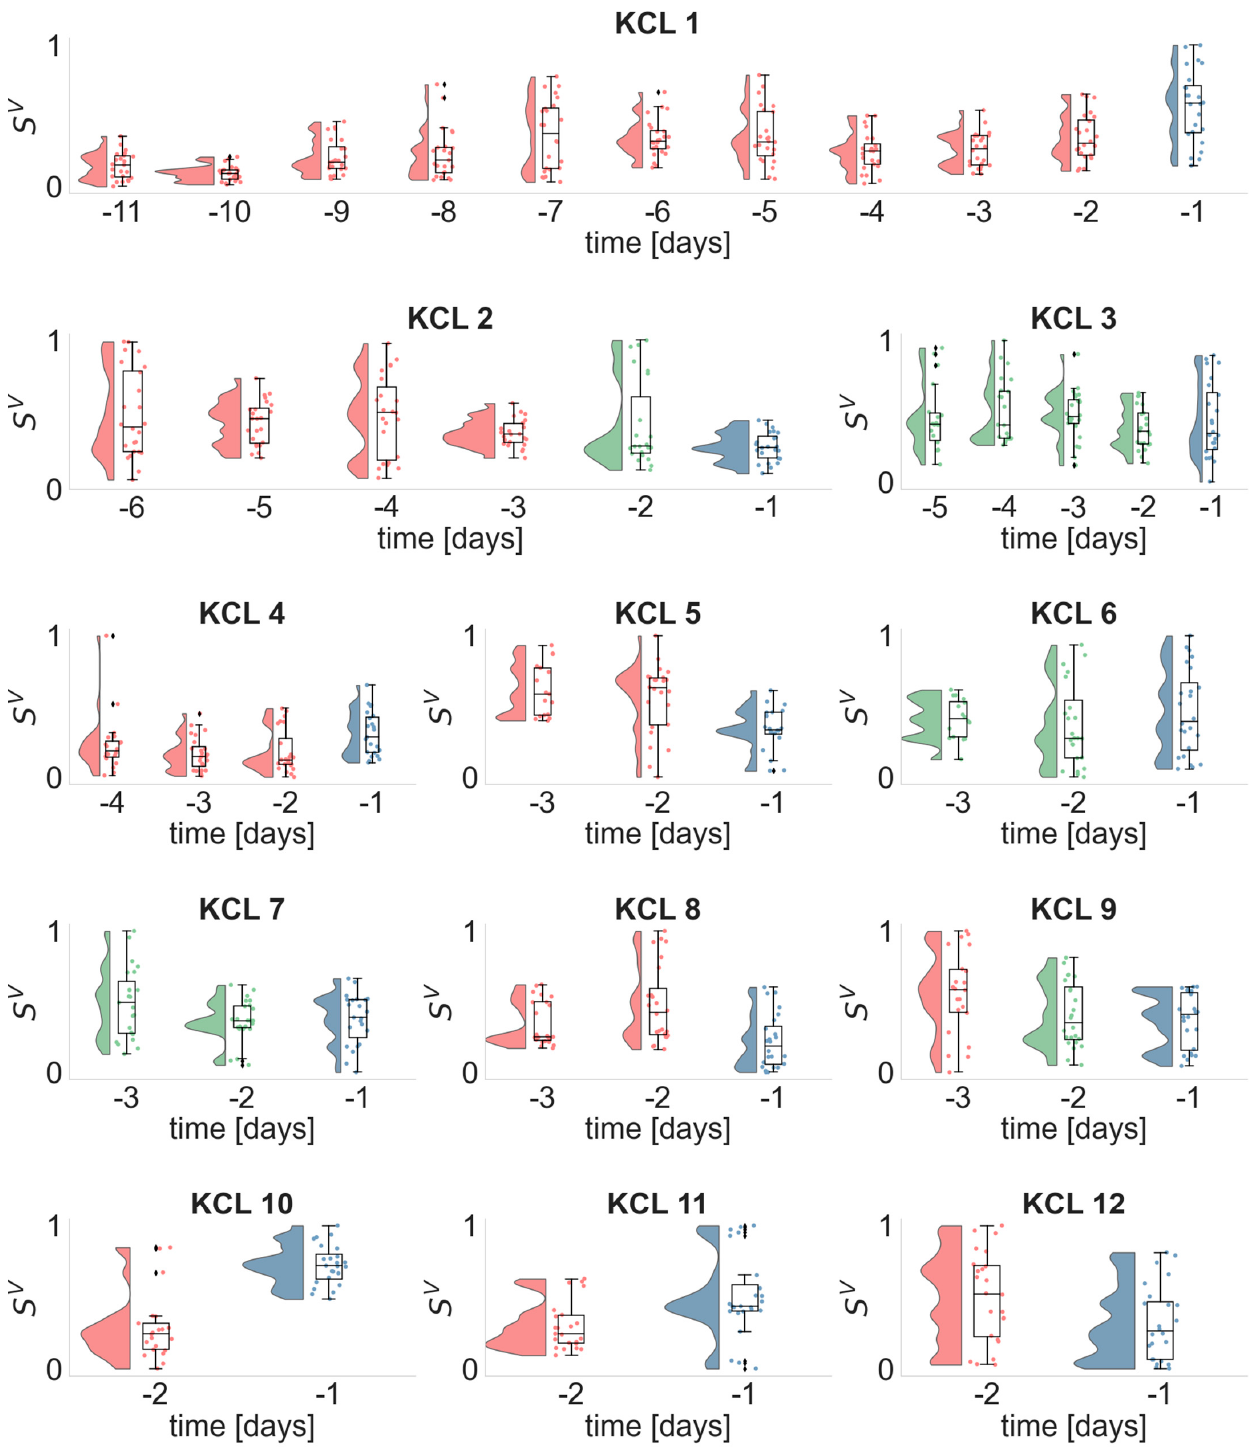
Figure 4. Daily distributions of the variance of strength S V (alpha frequency band) for each seizure free day prior to seizure occurrence. Dots illustrate the S V values obtained from each analyzed EEG segment, whilst histograms and boxplots depict their distribution. Horizontal lines in the boxplots indicate the median. The day before the seizure occurrence, i.e., d − 1 is denoted with blue. Days whose distributions are statistically significantly different (one-sided Wilcoxon rank sum test) from the distribution of day d − 1 are illustrated in red, otherwise are depicted in